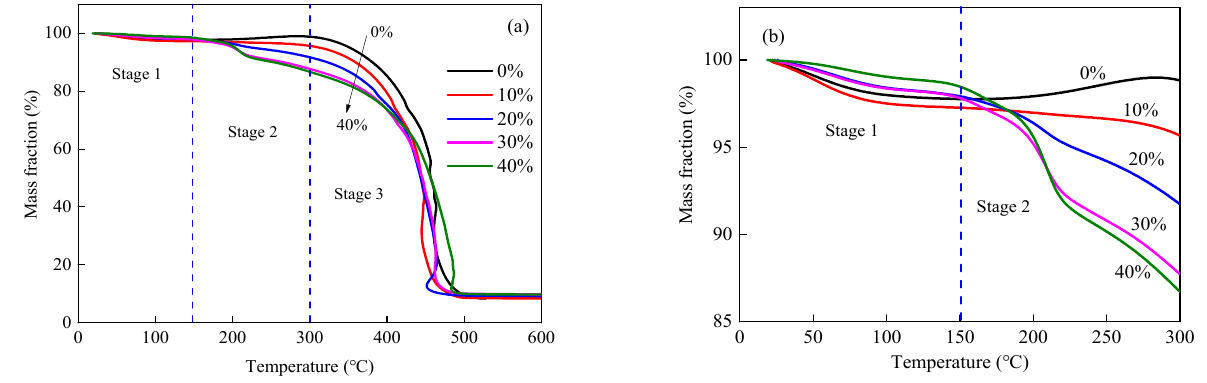
Figure 8. The mass fraction of the coal dust at 0–600 °C ( a ) and 0–300 °C ( b ).